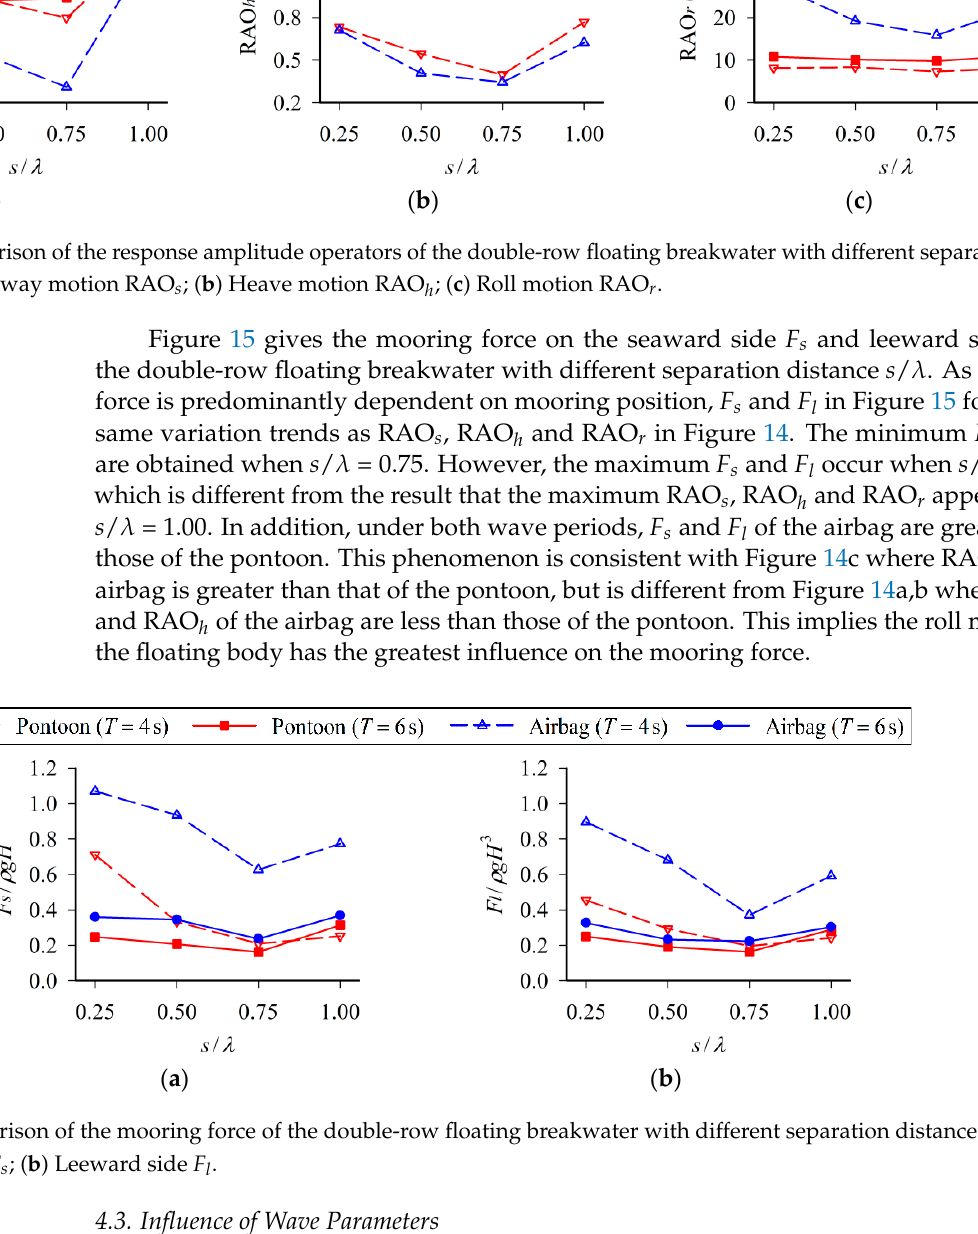
( b ) Figure 16. Comparison of the wave transmission coefficients C t of the double-row floating break- water under different wave parameters: ( a ) Wave height H = 1–4 m and wave period T = 6 s; ( b ) Wave height H = 3 m and wave period T = 4–7 s. Figure 17 shows RAO s , RAO h and RAO r of the double-row floating breakwater under different H and T . From Figure 17a–c, it can be seen that H has limited influence on RAO s , RAO h and RAO r of the pontoon. As for the airbag, since more wave energy is dissipated during the wave-pontoon interaction with the increase of H , the intensity of the leeward